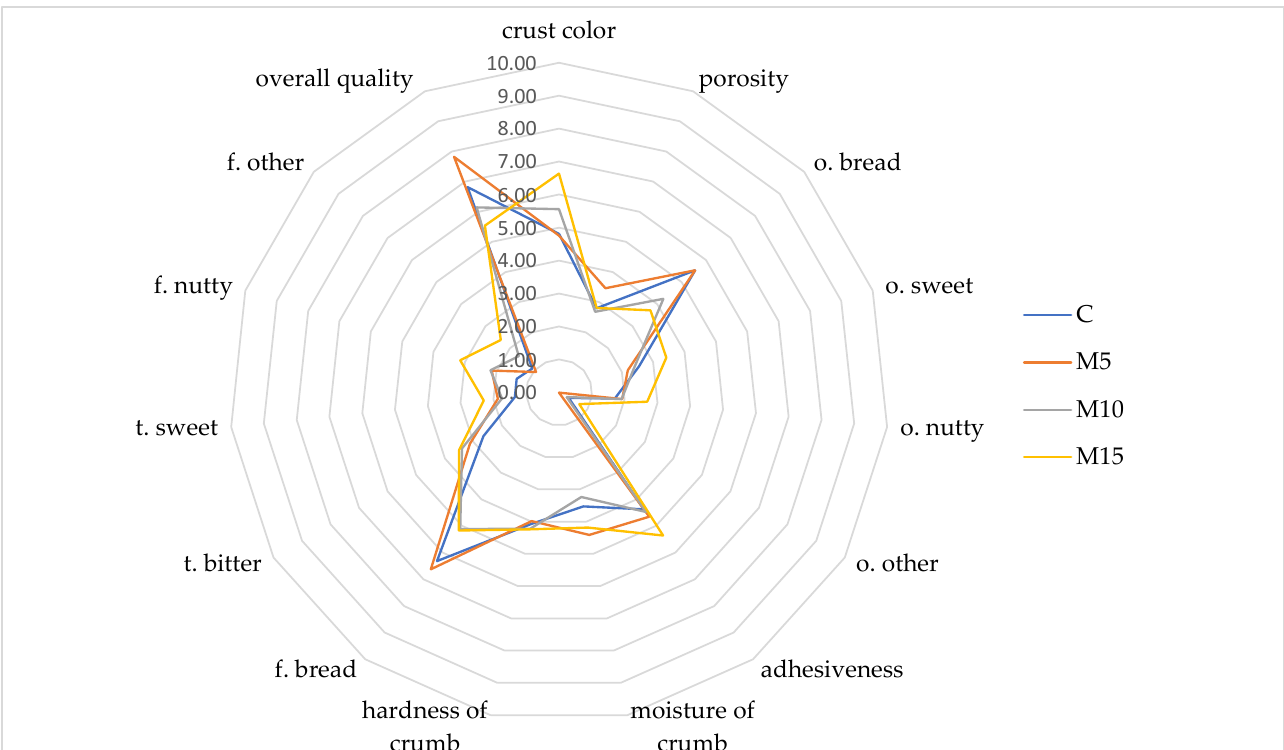
Figure 3. Sensory score plot of the breads with addition of mealworm powder (f.—flavor, t.—taste, o.—odor).